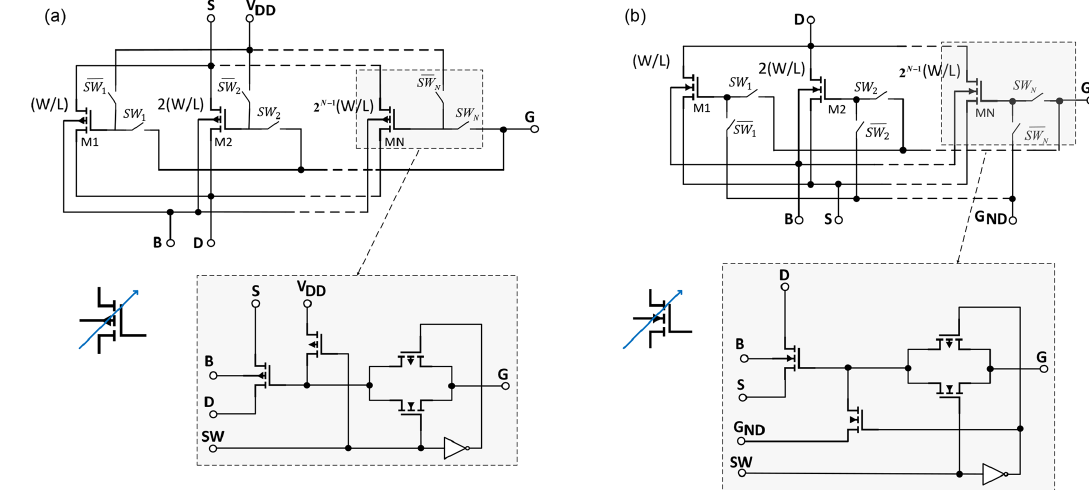
Figure 6. Scalable devices: (a) PMOS transistor and (b) NMOS transistor.